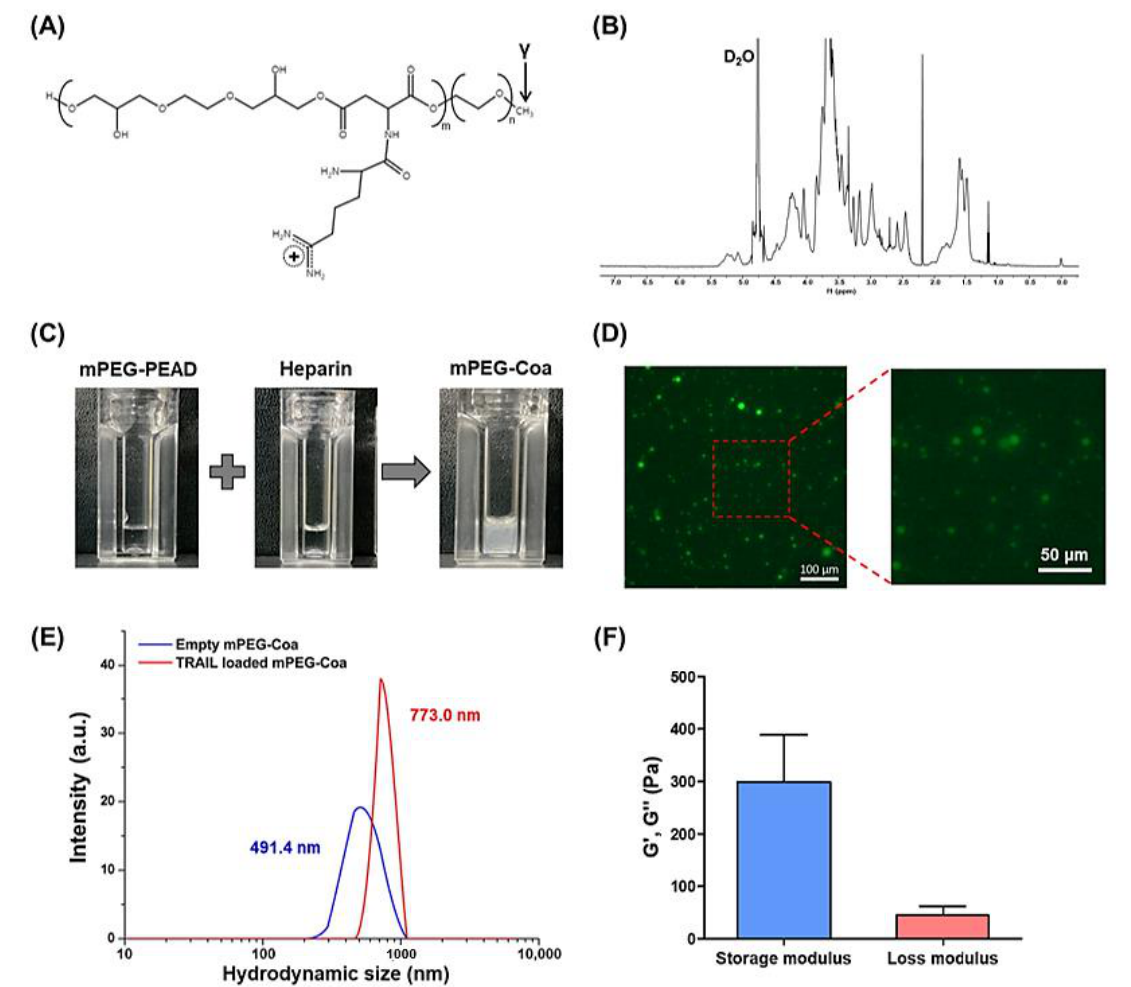
Figure 2. Characterization of mPEG-PEAD and mPEG-Coa. ( A ) Chemical structure of mPEG-PEAD and ( B ) structural analysis using 1 H-NMR. ( C ) Macroscopic observation of mPEG-PEAD, heparin, and mPEG-Coa and ( D ) fluorescence image of mPEG-Coa. ( E ) Hydrodynamic size of empty mPEG-Coa and TRAIL-loaded mPEG-Coa. ( F ) Viscoelastic properties of mPEG-PEAD.